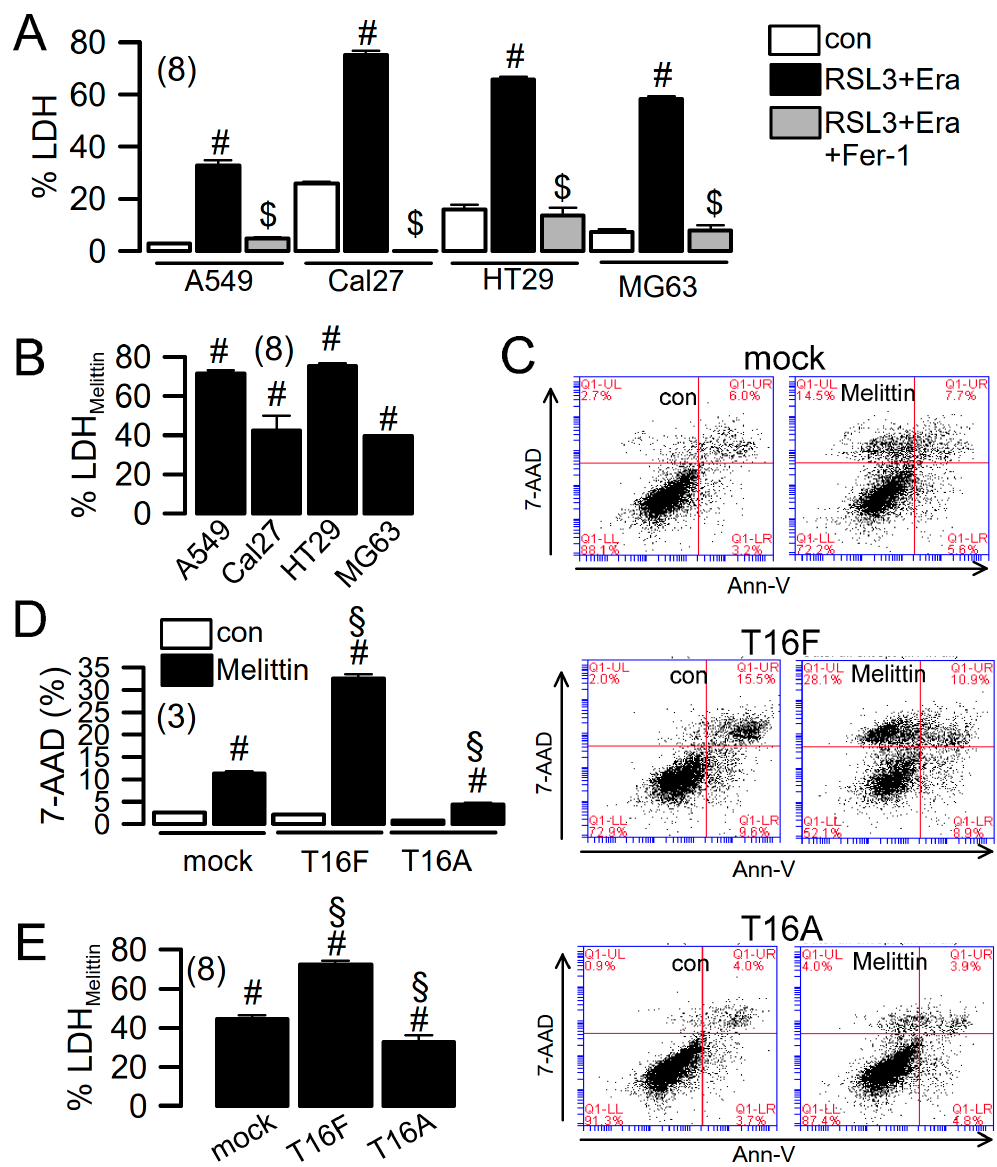
Figure 5. Cell death induced in cancer cells. ( A ) Summary of LDH release induced by RSL3 + Era (24 h) in human A549 pulmonary adenocarcinoma, Cal27 head and neck cancer, HT 29 colonic carcinoma, and MG-63 osteosarcoma cells, respectively. ( B ) Summary of LDH release induced in cancer cells by melittin (1 µM/14 h). ( C , D ) Dot blot indicating cell death induced by melittin in HEK293 cells expressing empty plasmid, TMEM16F, or TMEM16A, respectively. 7-AAD positivity indicating enhanced cell death in cells expressing TMEM16F. ( E ) Cell death induced by melittin, as detected by LDH release. Mean ± SEM (number of experiments). # Significant induction of LDH release or 7-AAD positivity, respectively ( p < 0.05, unpaired t-test). $ Significant inhibition by Fer-1 ( p < 0.05, unpaired t -test). § Significant di ff erence compared to mock ( p < 0.05,